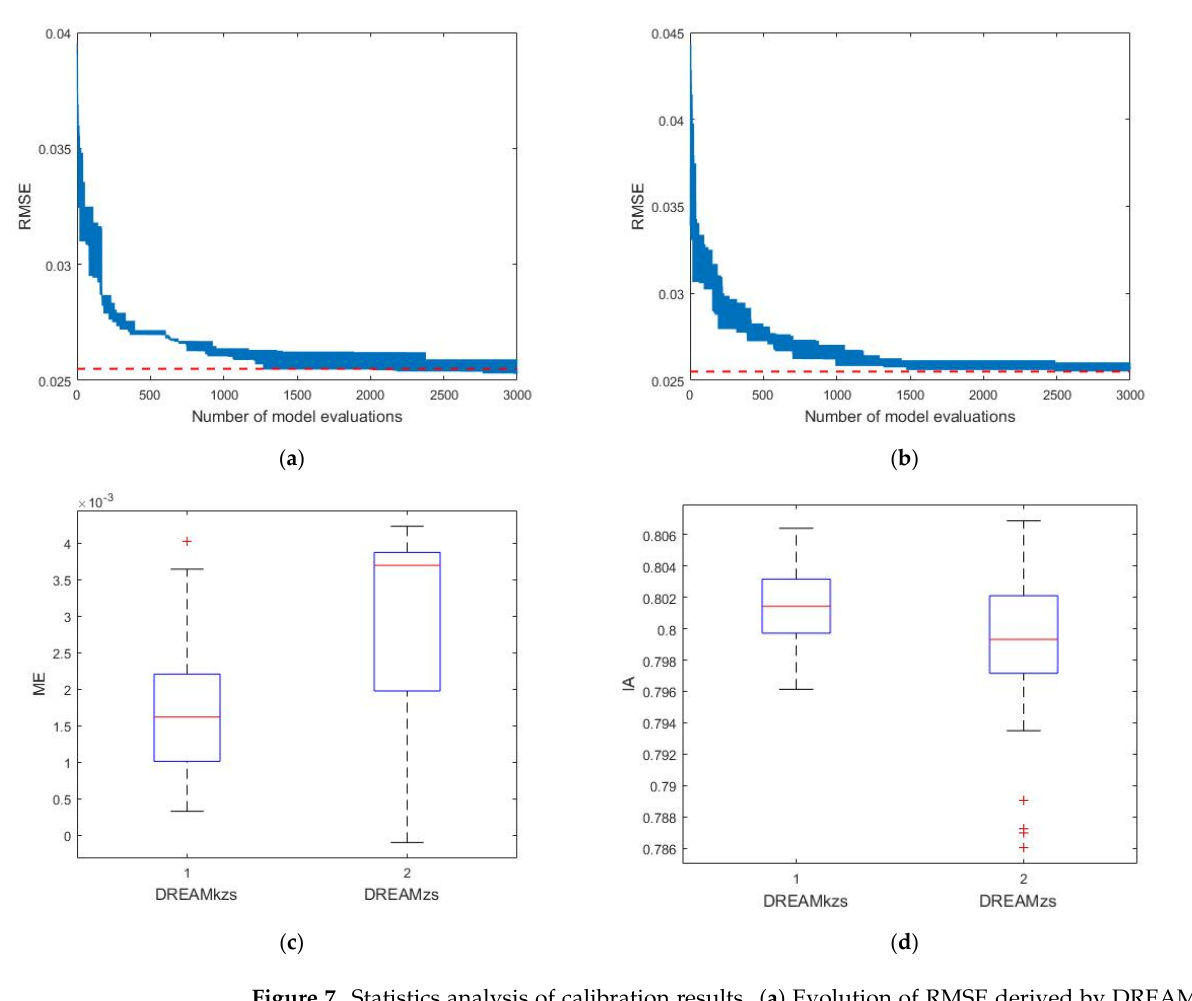
Figure 7. Statistics analysis of calibration results. ( a ) Evolution of RMSE derived by DREAMkzs. ( b ) Evolution of RMSE derived by DREAMzs. ( c ) Boxplots of ME. ( d ) Boxplots of IA.